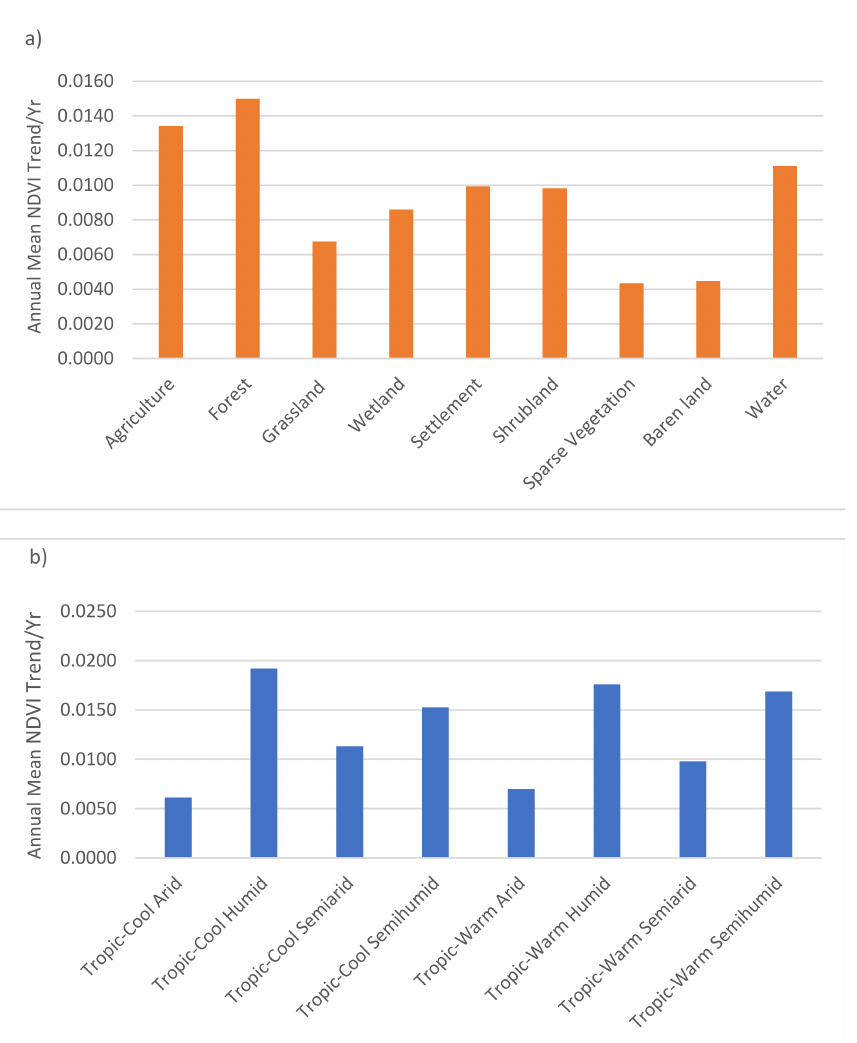
Figure 4. Annual mean NDVI trends per land cover type ( a ) and per agroecological zones ( b ) over the Horn of Africa during